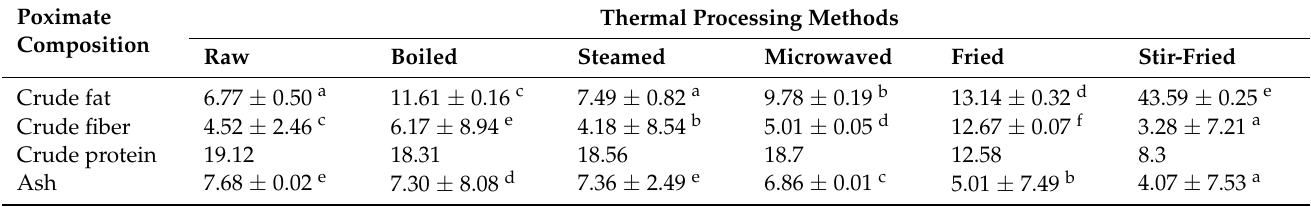
Table 1. Effects of different cooking methods on proximate composition of red cabbage.